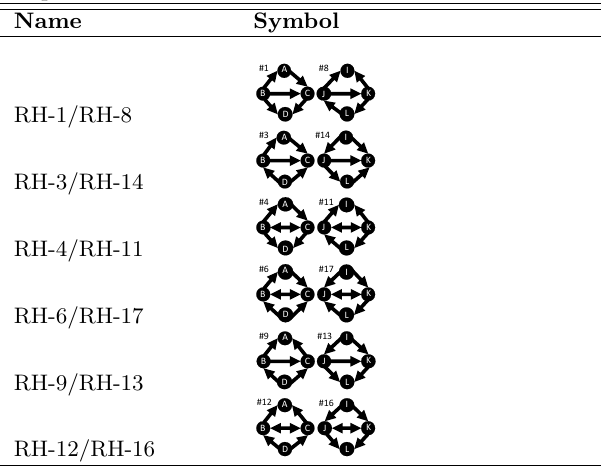
Table 3: Isomorphic rhombus motifs in E. coli tran- scriptional network.